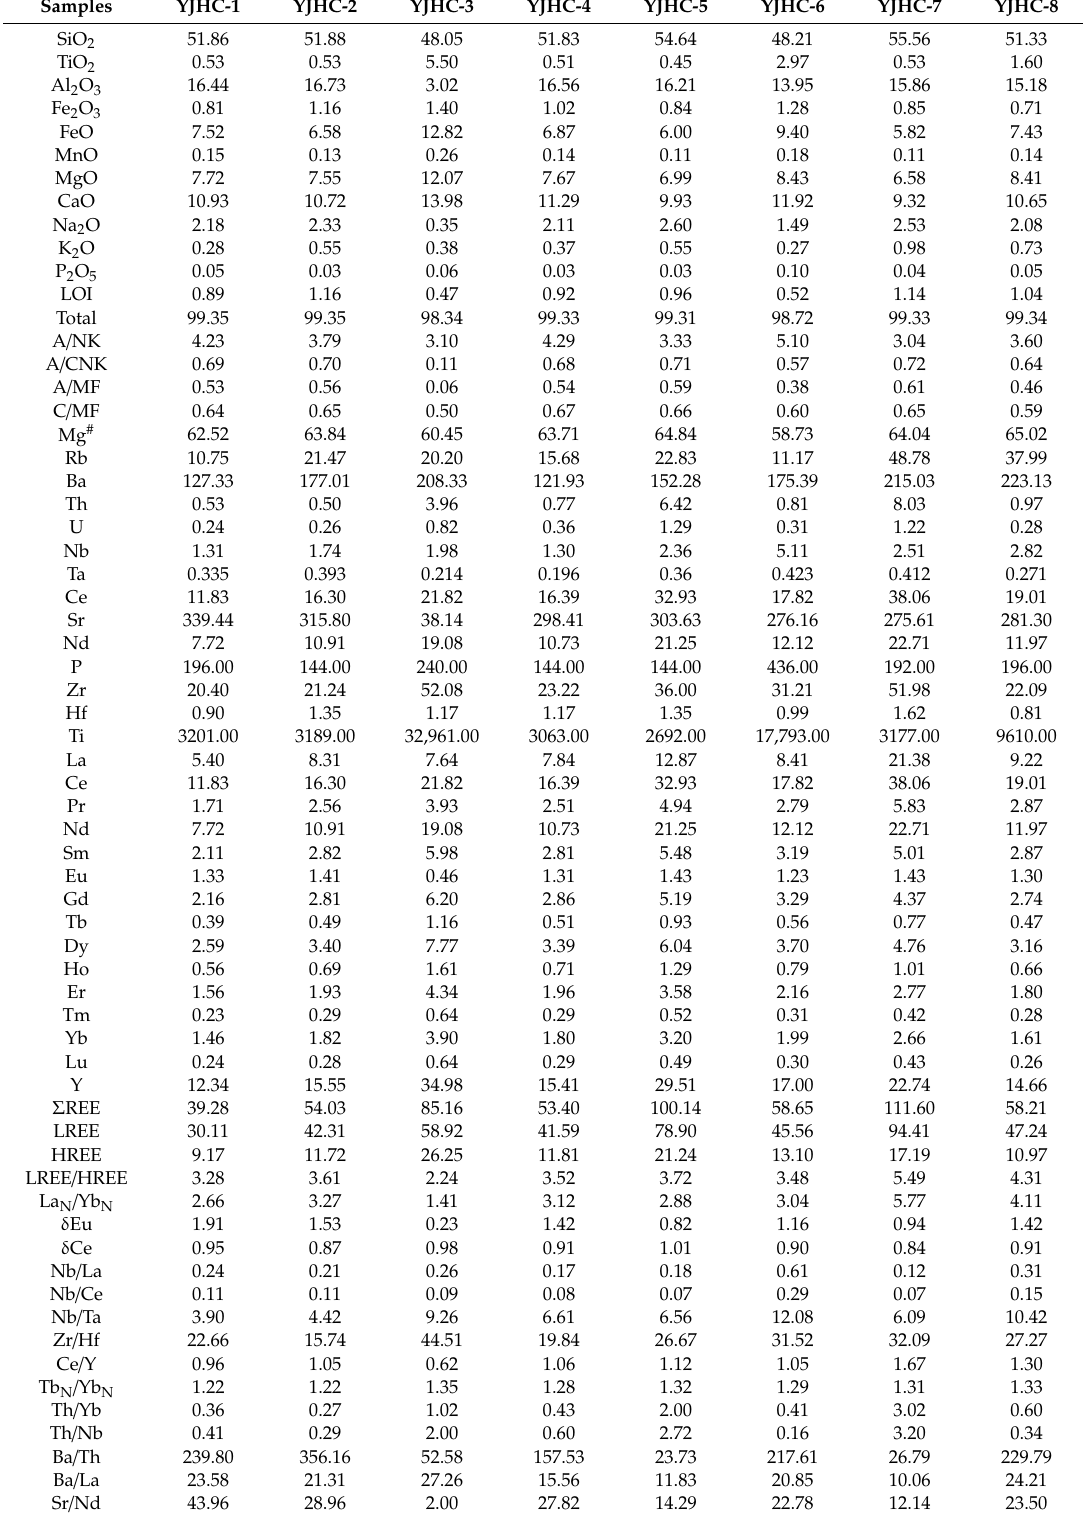
Table 1. Major (wt.%) and trace element (ppm) data for Yuejingshan gabbro.